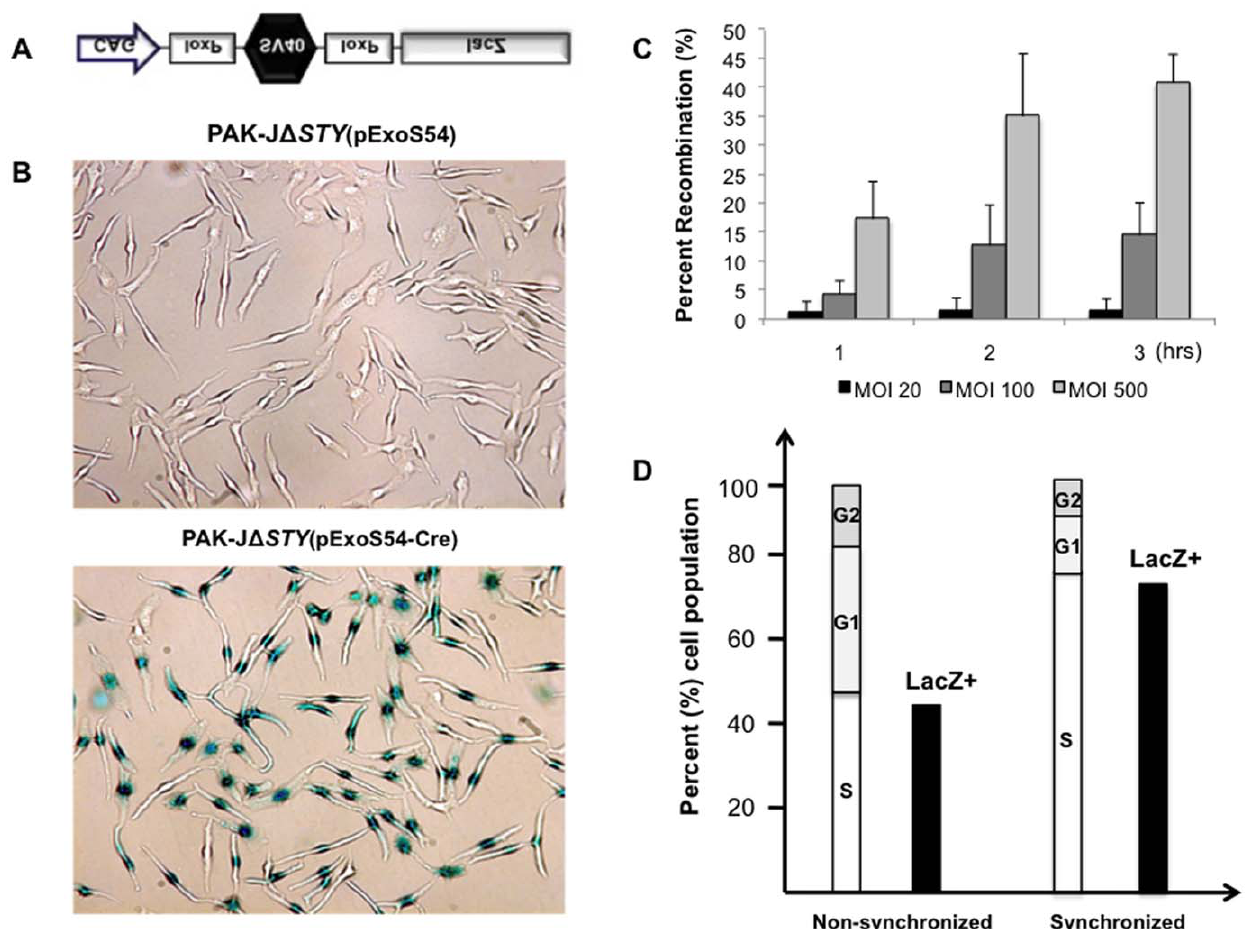
Figure 3. Assessment of Cre recombinase activity. Cre function was assessed by LacZ positive TE26 cells which contain a floxed terminator preventing lacZ expression ( A ). TE26 cells were infected for various times and MOIs and subsequently stained with X-gal for b -galactosidase ( B ) to determine the optimal infection conditions as indicated by percentage LacZ positive cells ( C ). TE26 cells were infected at an MOI of 50 for 3 hours before or after cell cycle synchronization and X-gal stained for b -galactosidase activity ( D ).